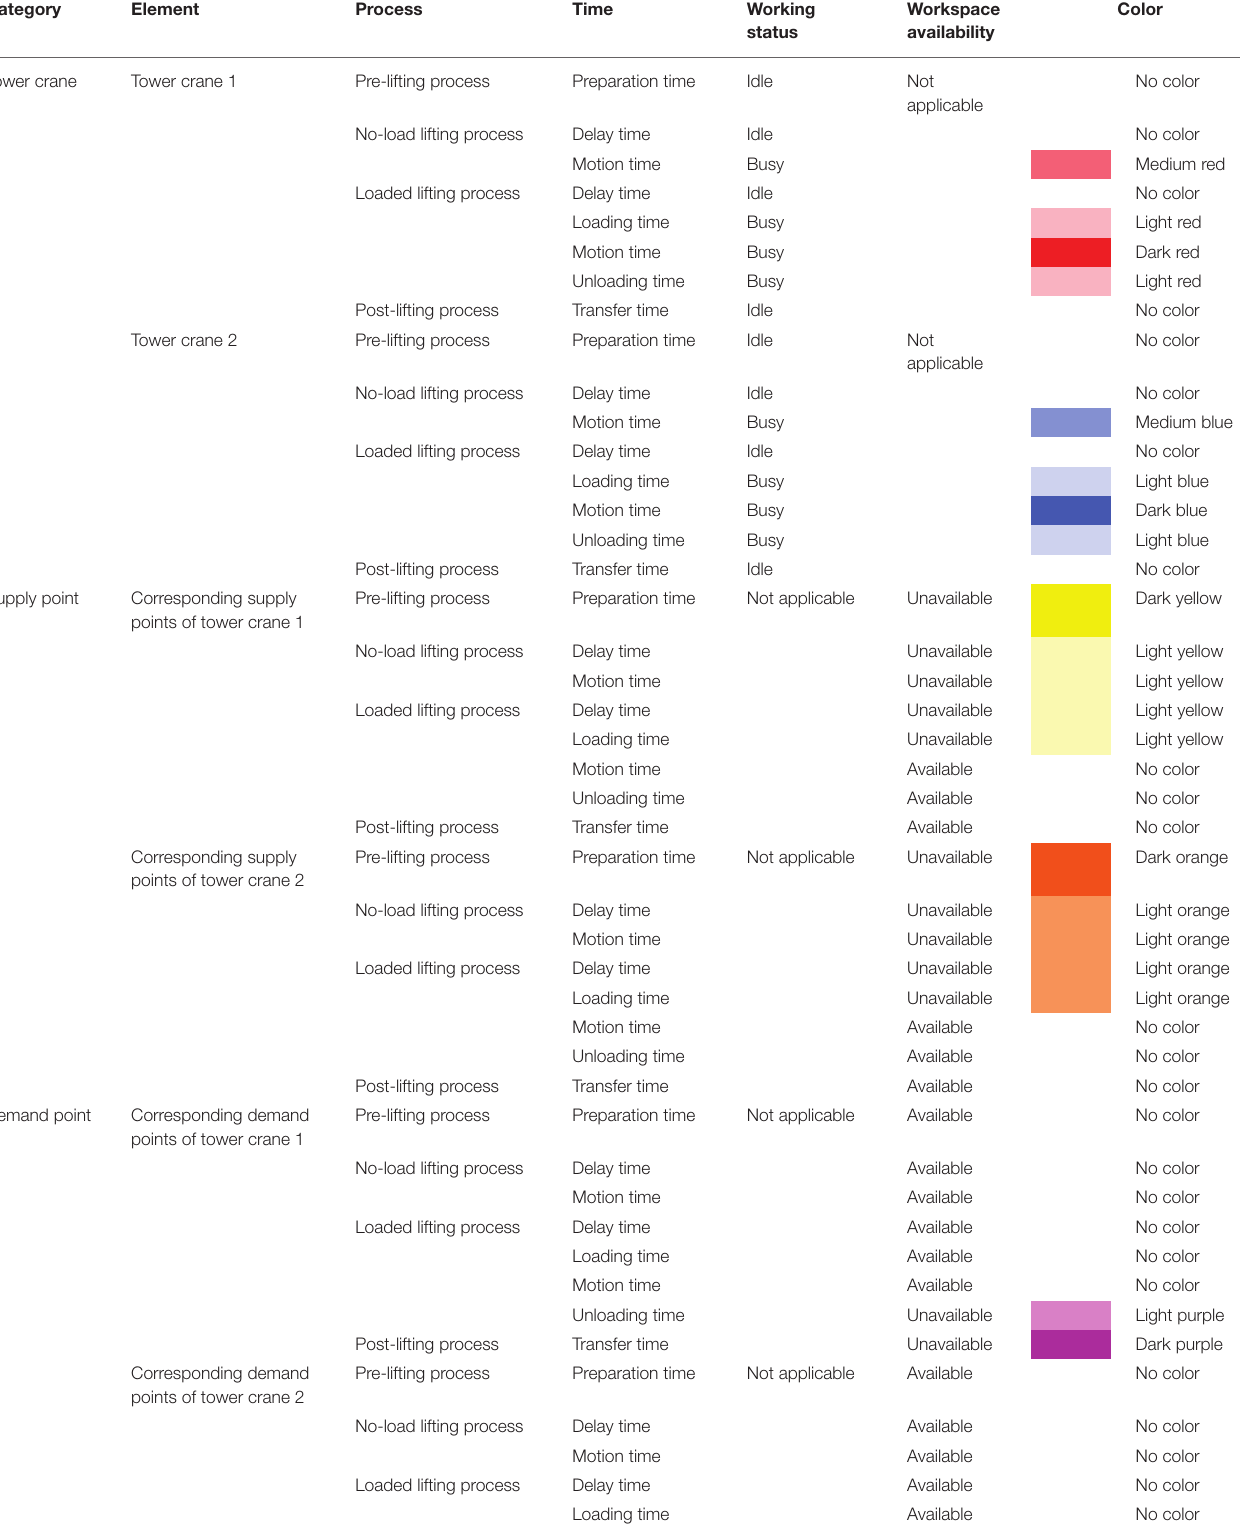
TABLE 2 | Example for the fine-level scheme. Category